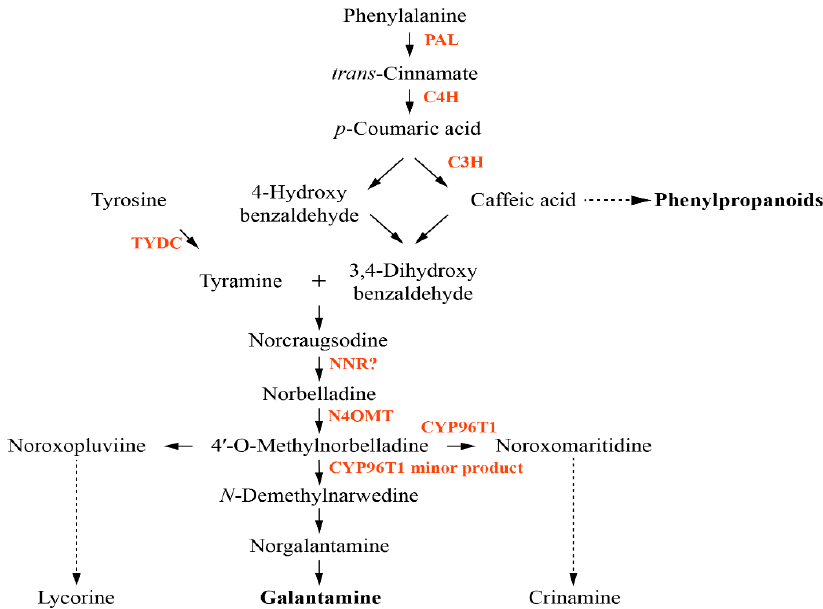
Figure 1. Proposed biosynthetic pathway for galantamine. Enzymes involved in the pathway are indicated in red. PAL, phenylalanine ammonia lyase; C4H, trans -cinnamate 4-monooxygenase; C3H, p -coumarate 3-hydroxylase; TYDC, tyrosine decarboxylase; NNR, noroxomaritidine / norcraugsodine reductase; N4OMT, norbelladine 4‘- O -methyltransferase.